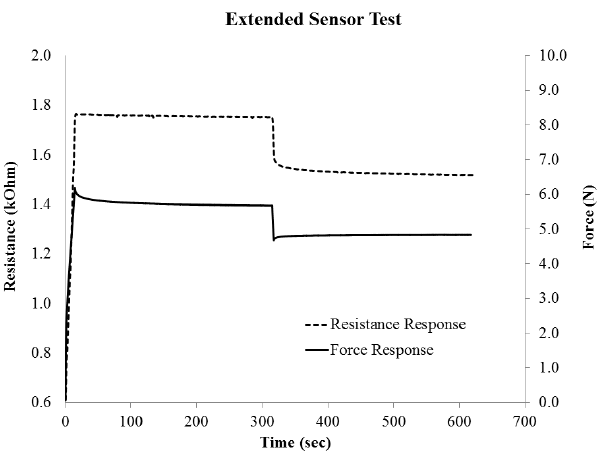
Figure 11. Characteristic band sensor tensile strain behavior held at 30% and then 25% strain for 5 min at each strain level.